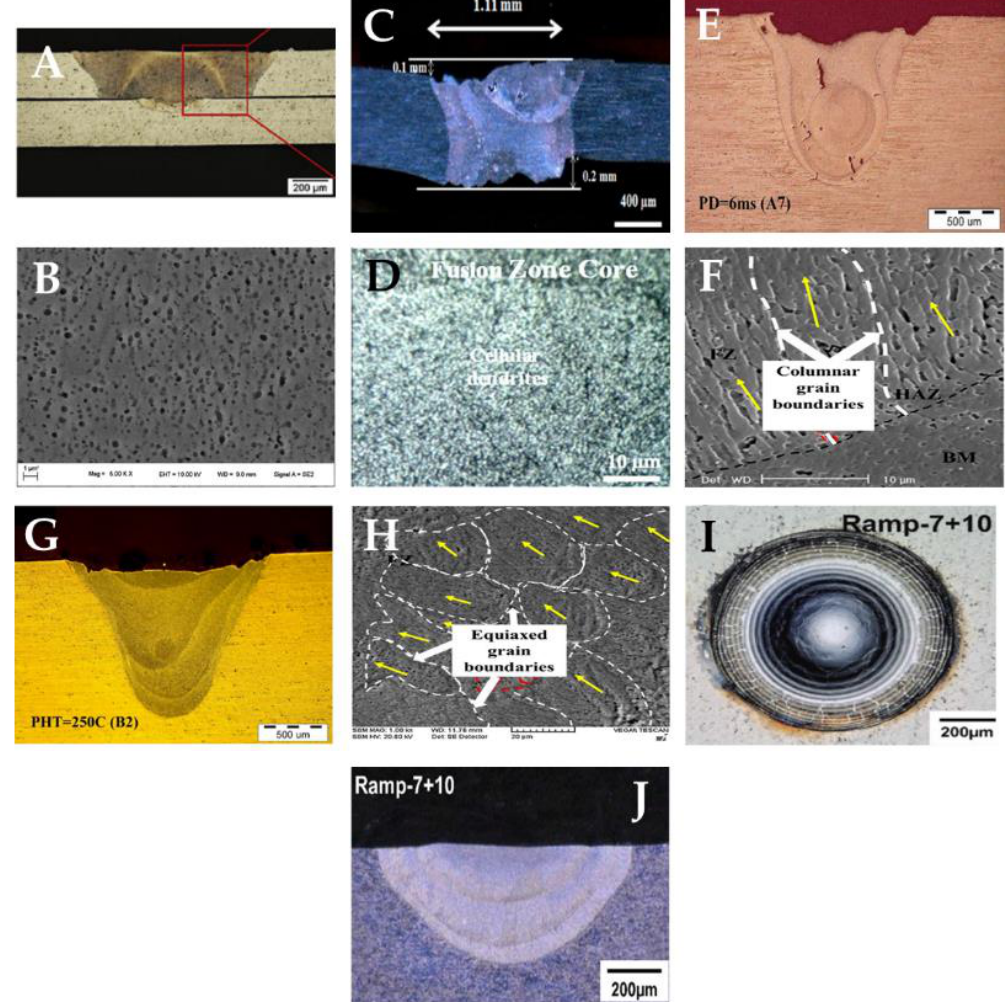
Figure 14. Pulsed laser weldments made of aluminium: AA5052 ( A ) and its FZ ( B ) [89]; AA5052-H32 ( C ) and its FZ ( D ) [9]; AA5456 ( E ) and its weld interface ( F ); AA5456 after PWHT ( G ) and its FZ ( H ) [26]; and AA5083 spot ( I ) and its cross-section ( J ) [98].